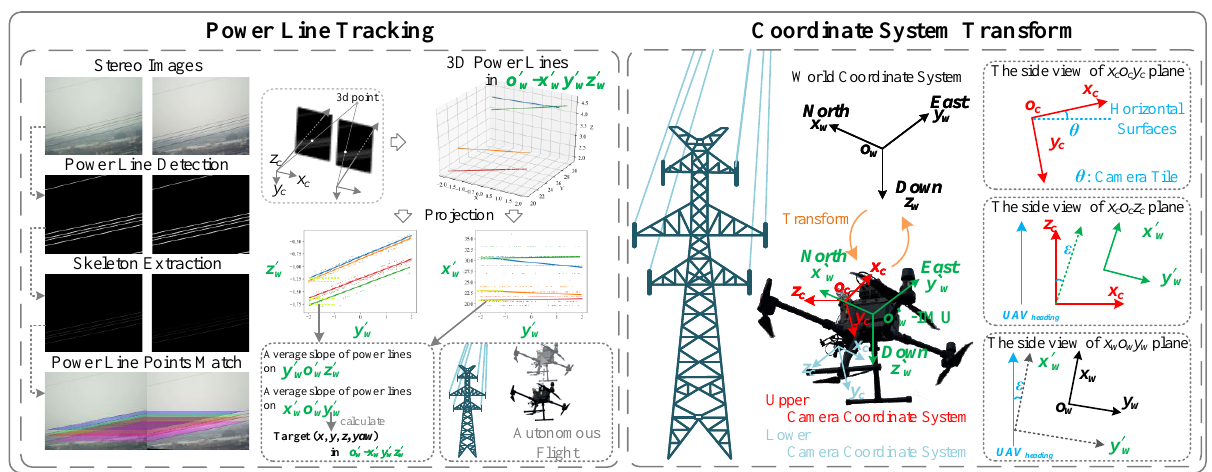
Figure 5. Details of the proposed power line tracking algorithm and the transformation of different coordinate